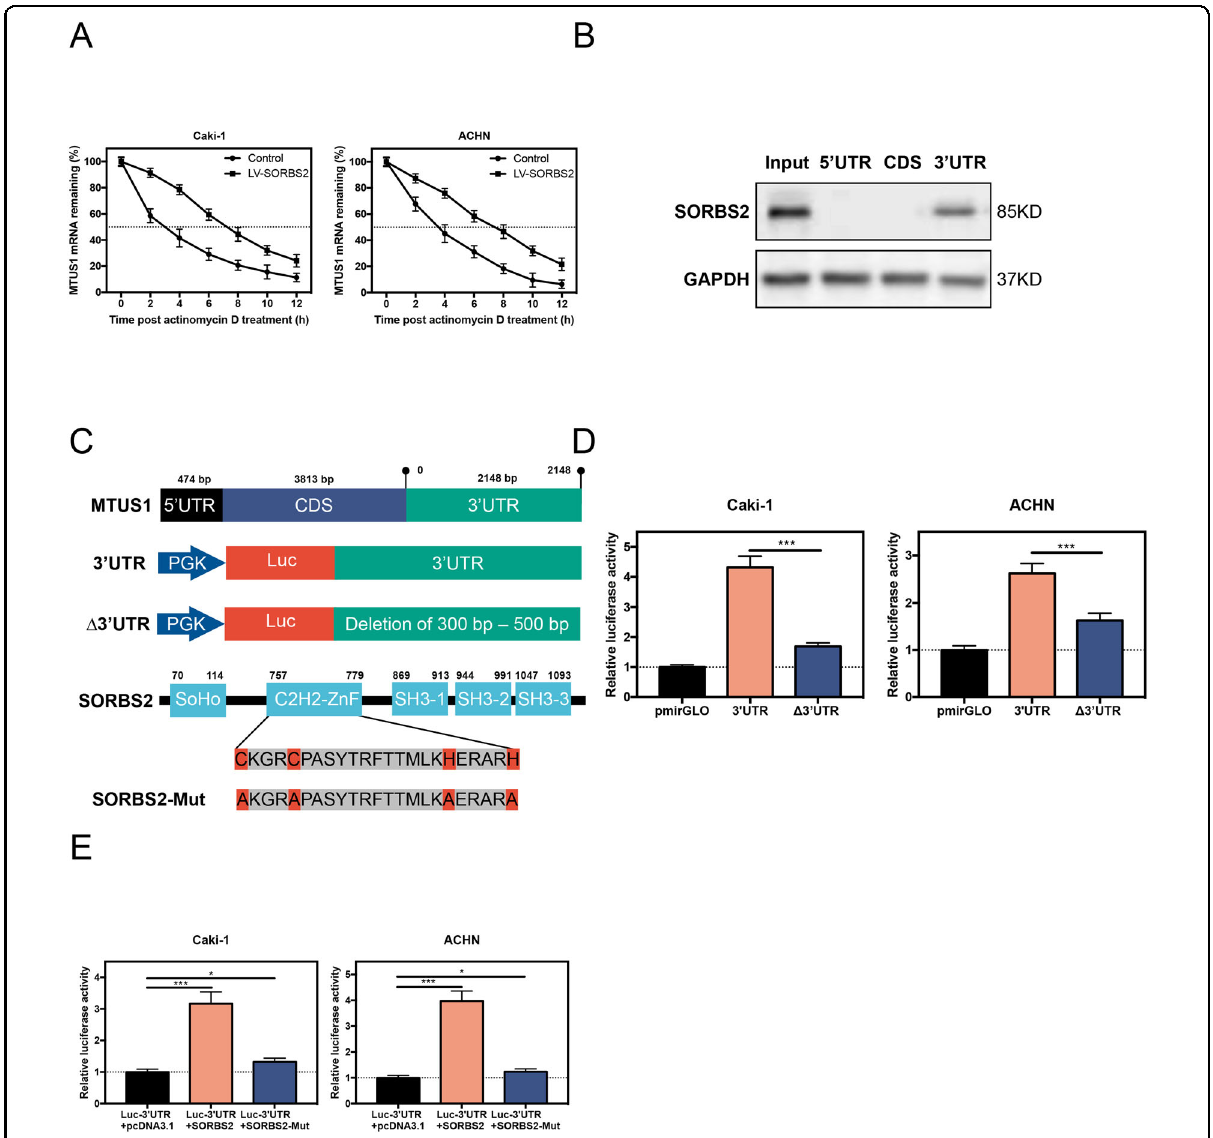
analysis of potential binding sequence of SORBS2 to MTUS1 mRNA. C Schematic presentations of constructs. D , E Luciferase reporter assay to determine the binding domain between SORBS2 protein and MTUS1 mRNA. * P < 0.05; *** P <